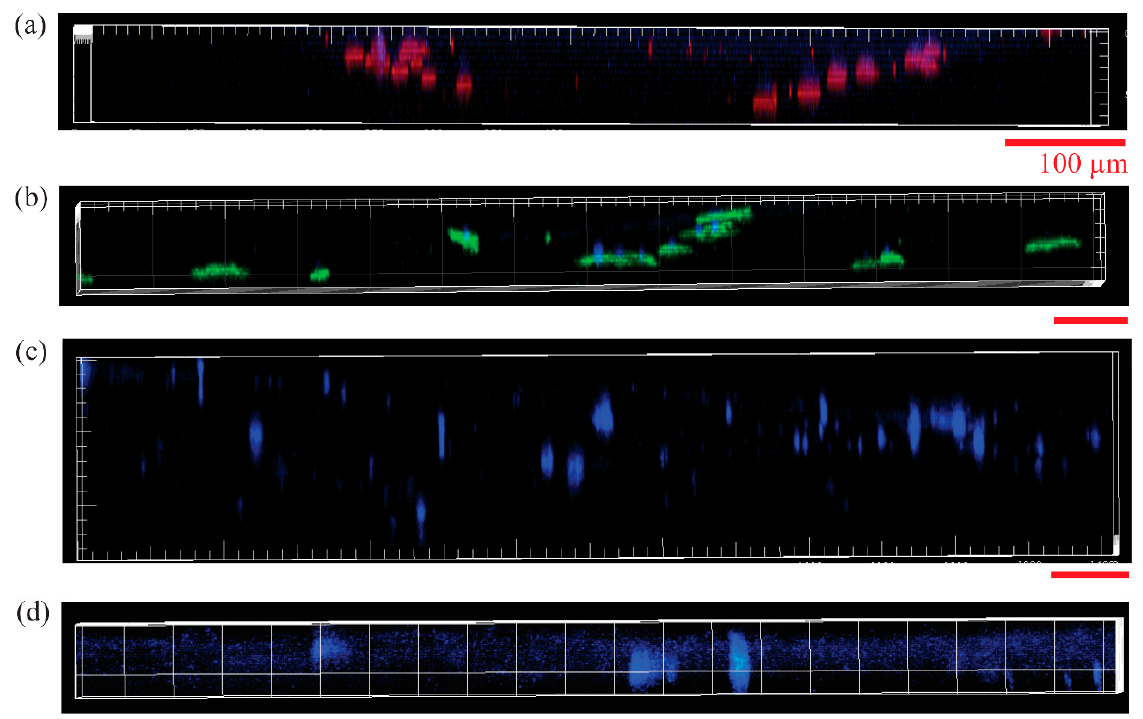
Figure 8. Confocal microscope images showing the infiltration of HEKa cells seeded onto ( a ) control and ( b ) PCL/CA scaffolds, and HDFa cells seeded onto ( c ) control and ( d ) PCL/CA scaffolds (KRT1 (green), KRT5 (red), filaggrin (purple), and DAPI (blue)). All scale bars correspond to 100 µm and are applicable for the horizontal and vertical axes of the images. The antibodies shown in ( a , b ) do not indicate exclusivity of expression; these images are only used to visualize the infiltration depth.